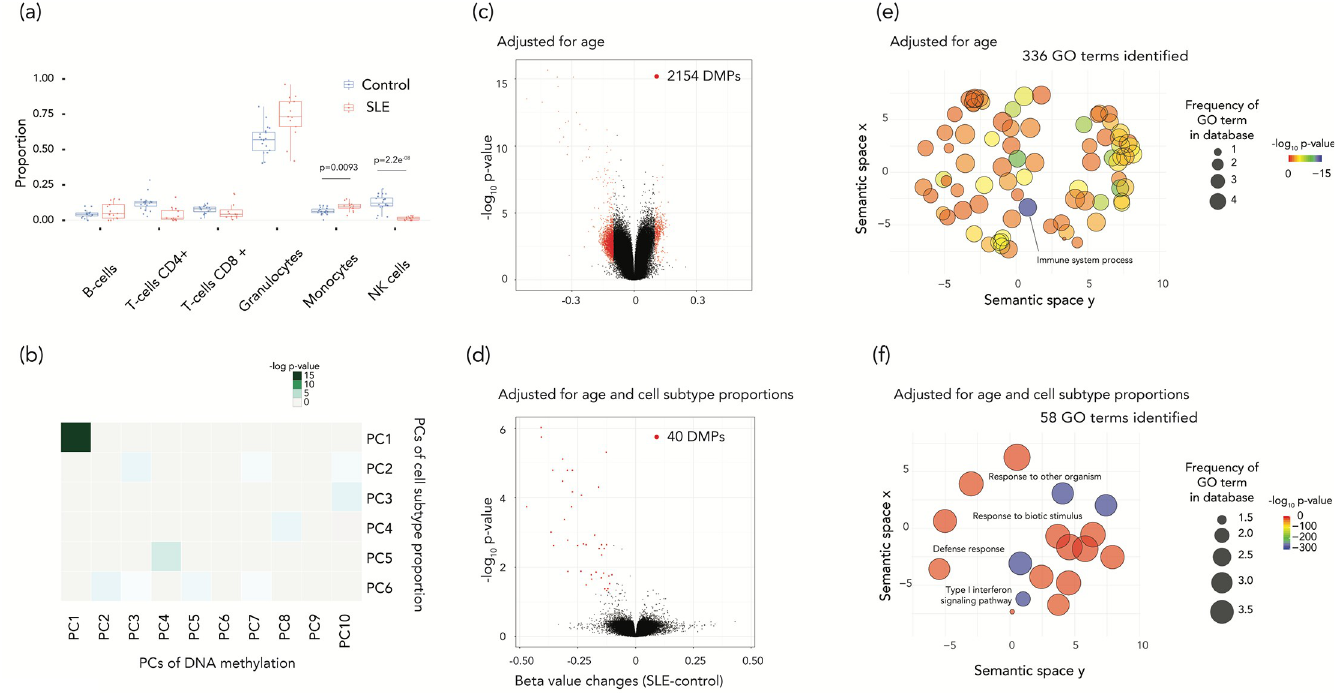
Fig 2. Disease status associated cell subtype proportion changes reflect the DNA methylation changes between SLE and control samples and the disease-related pathways were highlighted after the cell subtype proportion adjustment. (a) The cell subtype proportion changes in SLE were driven predominantly by two cell types. The proportion of monocytes in increased in SLE (p = 0.0093, t-test). On the other hand, the proportion of natural killer (NK) cells is lower in patients with SLE (p = 2.2e -08 , t-test). (b) Principal components for DNA methylation with significance of association of PCs for the estimated cell subtype proportions are shown as a heat map. The first principal components were significantly associated each other. (c-d) Two volcano plots show differentially-methylated probes (DMPs). (c) shows the results of DMPs adjusted for age alone and (d) shows results also adjusted for cell subtype proportions. Almost all DMPs were eliminated after the adjustment for cell subtype proportions. (e-f) GO analysis results are summarized as REVIGO scatterplots. (e) shows the results of age-adjusted and (f) the results for age and cell subtype proportion adjusted terms. The x and y axes indicate the semantic similarity of each GO term. The bubble color indicates log 10 p-values, and size represents the percentage of genes annotated with the GO term in the human